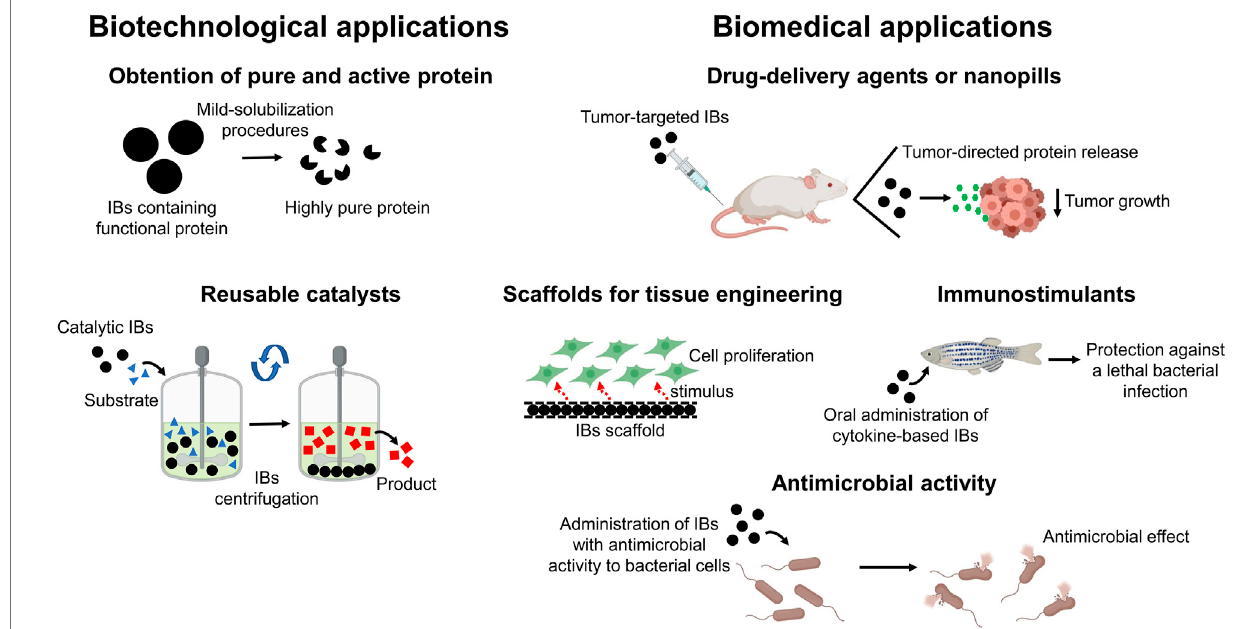
FIGURE 2 | Biotechnological and biomedical applications of functional IBs. Functional IBs can be exploited for biotechnological purposes as a source of pure and activeproteinandasreusableandimmobilizedcatalysts.Regardingtheiruseinbiomedicalapplications,IBscanactastargeted-nanopills,asbiocompatiblescaffoldsfor tissue engineering, as immunostimulants to act against lethal infections or as antimicrobial agents.